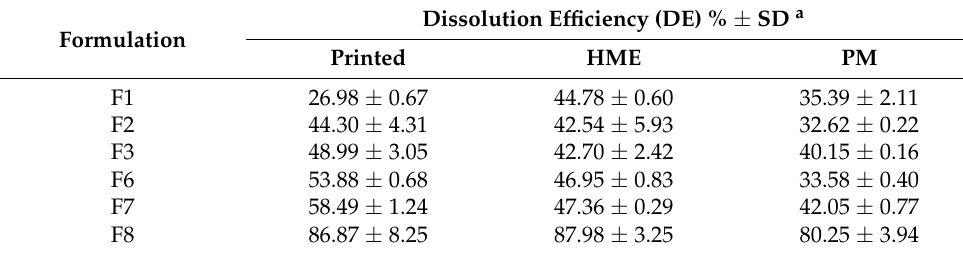
Table 9. Dissolution efficiency of tablets obtained via different techniques.